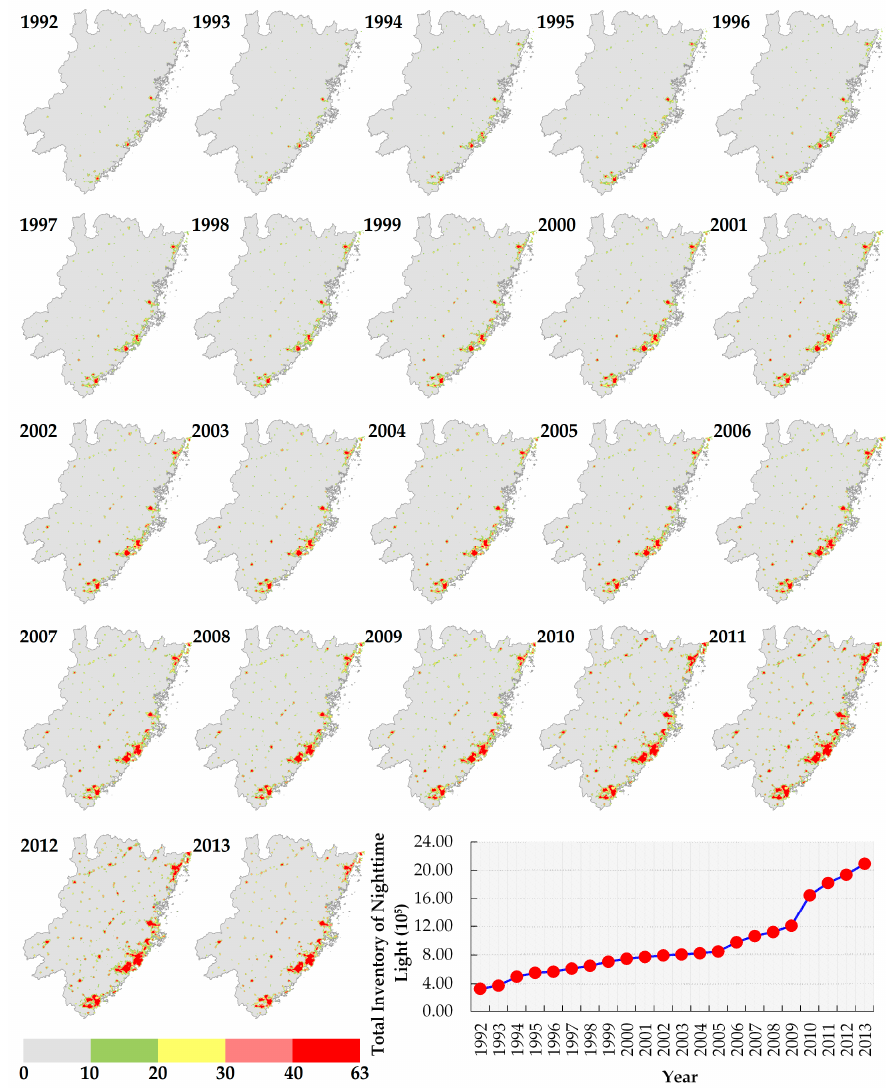
Figure 2. Spatio-temporal change of nighttime light from 1992 to 2013 in WTSUA.